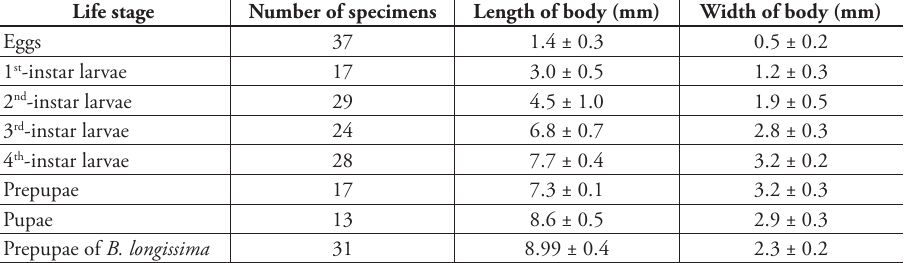
Table 1. Measurements (mean value) of each life stage of O. nipae and prepupae of B. longissima . Life stage Number of specimens Length of body